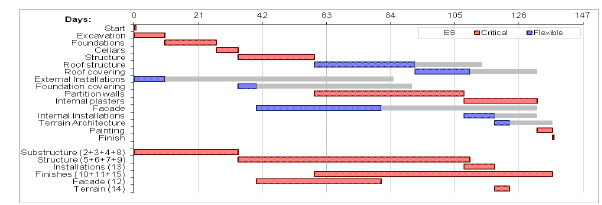
Figure 7: The project schedule for the maximization of project NPV with the priority for works with higher direct cost.